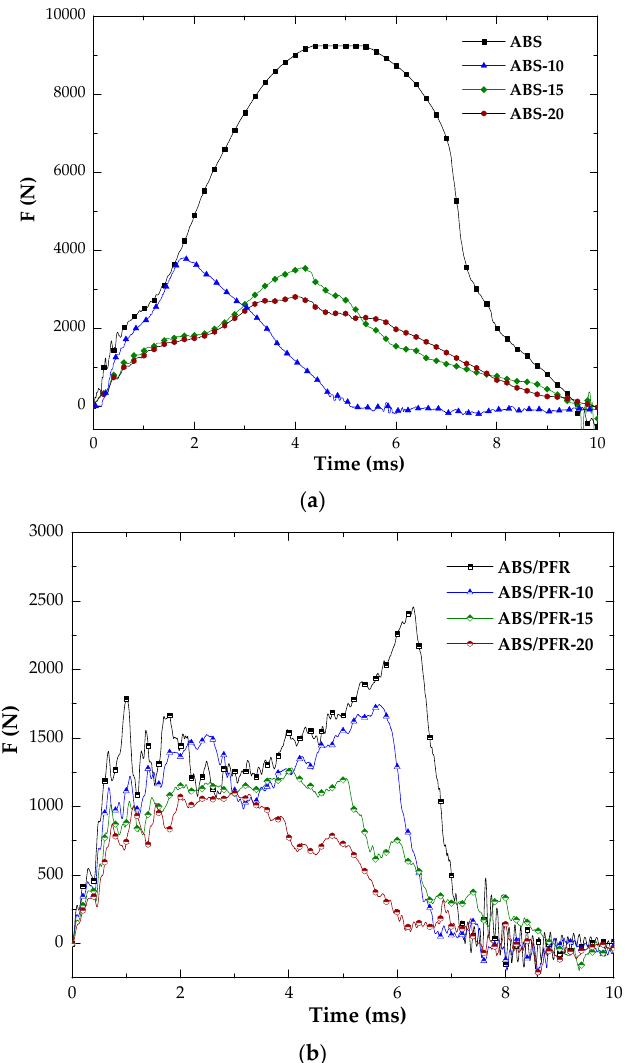
Figure 10. Characteristic force versus time falling weight curve of unfoamed and foamed ( a ) ABS and ( b ) ABS/PFR.